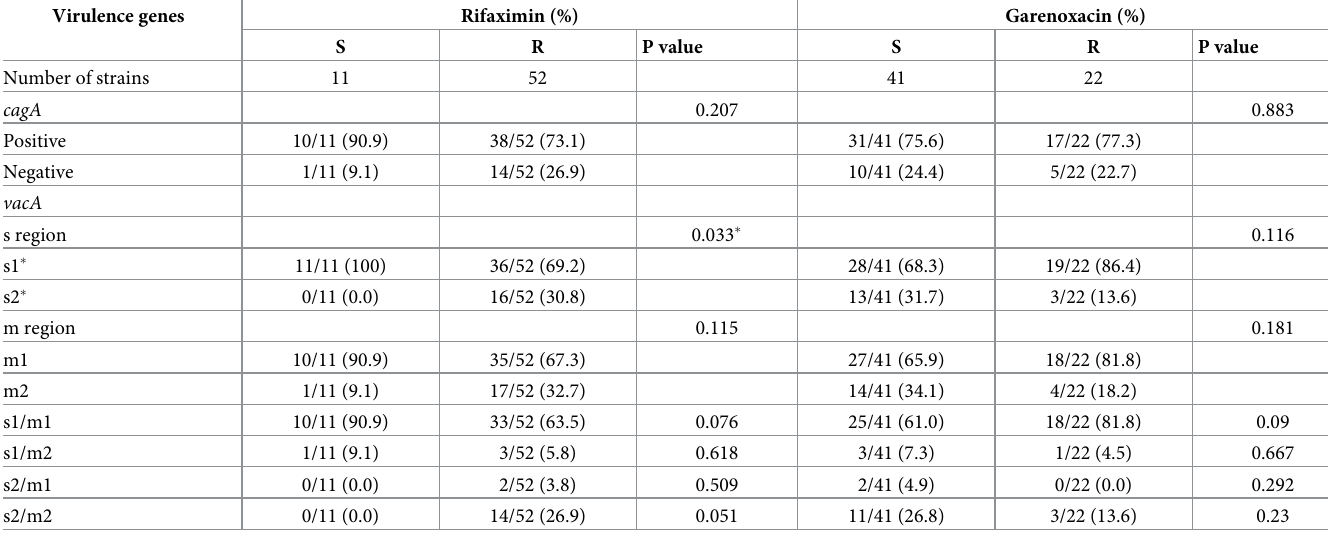
Table 6. Association between virulence genes and resistance